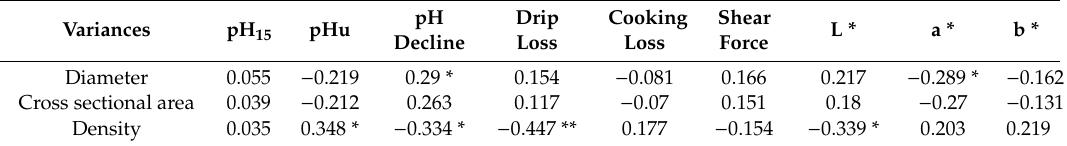
Table 7. Partial correlation coe ffi cients between myofiber characteristics and meat quality traits. Variances